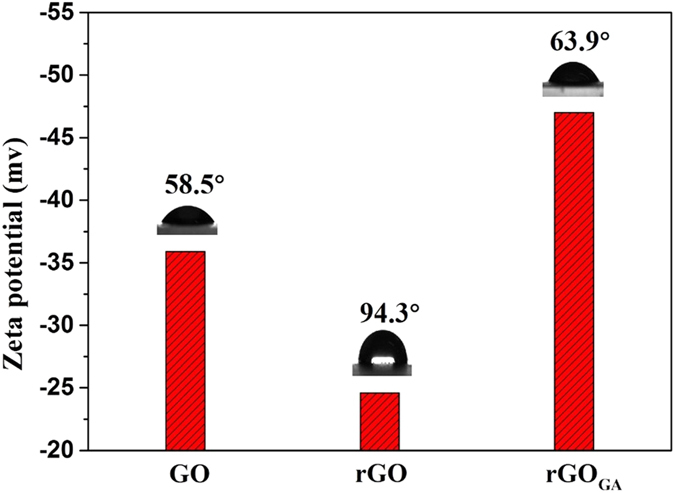
Zeta potential and contact angle of GO, rGO and rGOGA.